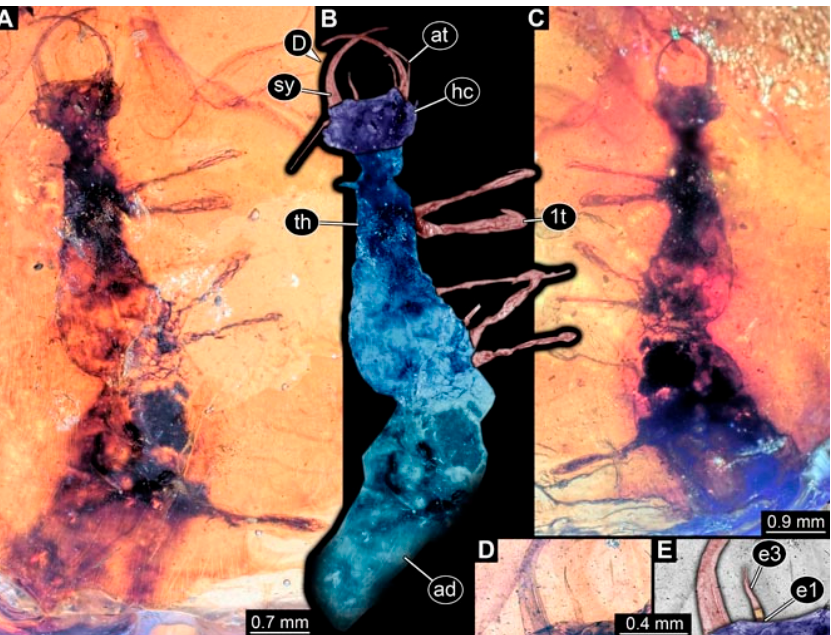
Figure 12. Specimen 4831 (PED 0149); Myanmar amber. ( A ) Dorsal view. ( B ) Dorsal view, colour- marked. ( C ) Ventral view. ( D ) Close-up of labial palp in dorsal view. ( E ) Close-up of labial palp in dorsal view, colour-marked. Abbreviations: 1t = first trunk appendage (walking leg); ad = abdomen; at = antenna; e1, e3 = element 1, 3; hc = head capsule; sy = stylet; th = thorax.